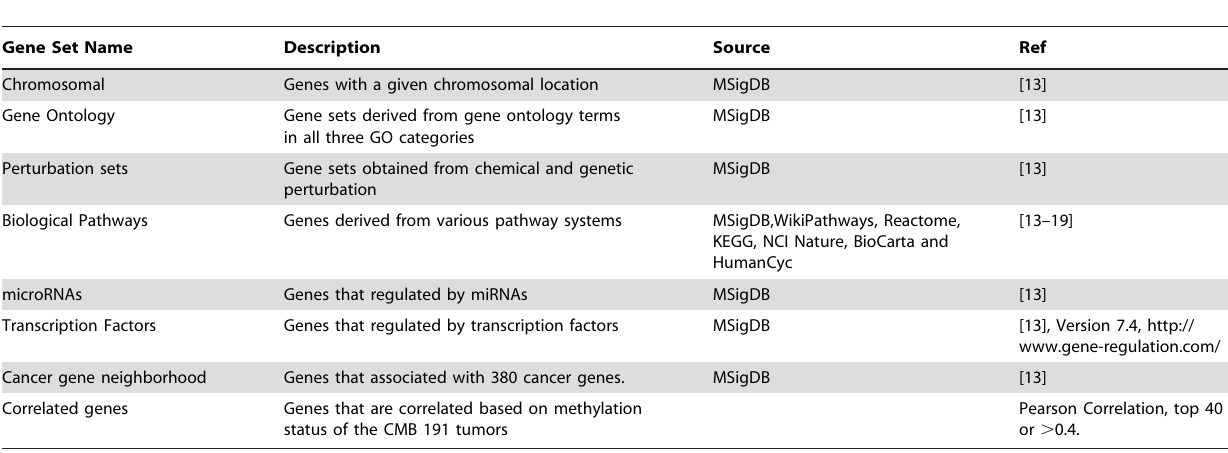
Figure 2. Gene centric view of CMS. This webpage is designed for visualization and analysis of methylation intensity at the gene level. In the toolbar, four layers of options are available to enable specific selections gene sets. Methylation intensities for promoter regions of genes ( + / 2 2 kb around TSS region) were pre-calculated and were shown using a red gradient heatmap. A white/green box on the side of gene symbol shows the promoter regions of this particular gene with or without CpG island(s). Clicking on the gene symbol on the left side of the heatmap panel will bring the user back to the genomic viewer centered on the selected gene, allowing visualization of detail methylation patterns. doi:10.1371/journal.pone.0060980.g002 as that of genomic view. Promoter regions with or without CpG use of CMS section) between different tumor types, or among the island(s) are annotated with a white/green box on the side of gene genes within similar biologically significant categories. symbol. The heatmap panel makes it possible to visualize Clicking on the gene symbol on the left side of the heatmap different/similar/special methylation profiles (See Discovery by panel will bring the user back to the genomic viewer centered on Table 1. Eight classes of gene set names and their